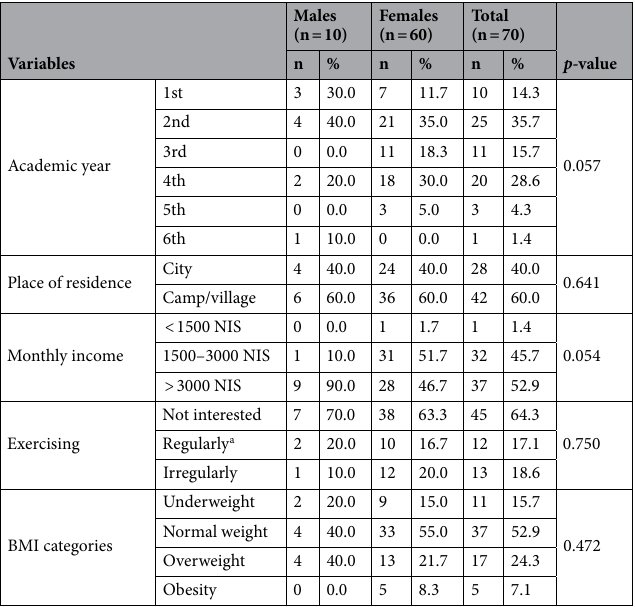
Table 1. Participant characteristics according to their gender presented in numbers (n) and percentages (%). Sociodemographic characteristics, lifestyle habits, and body weight status. NIS, new Israeli Shekel. a 30 min of moderate-intensity exercise at least 5 days per week.